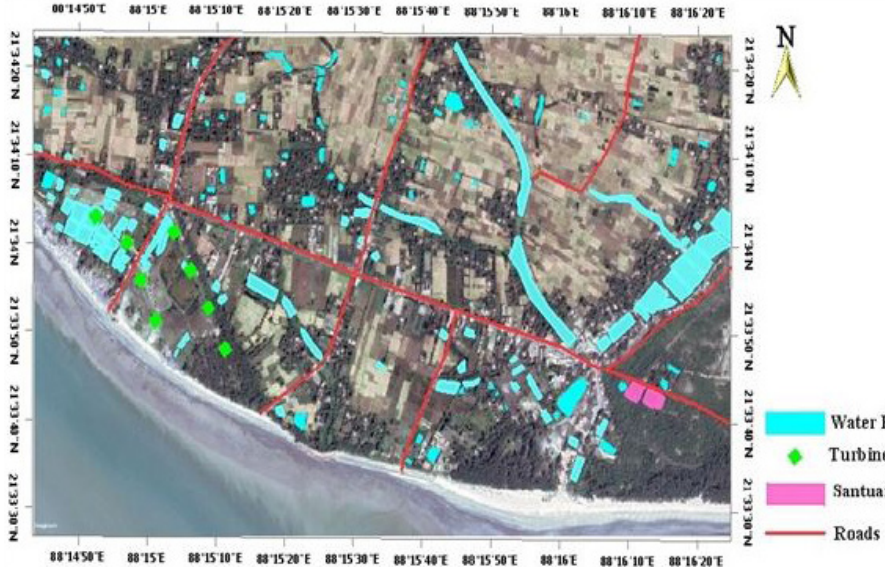
Figure 2. Exact location of wind farms in the study area at Location-3 near Bakhkali